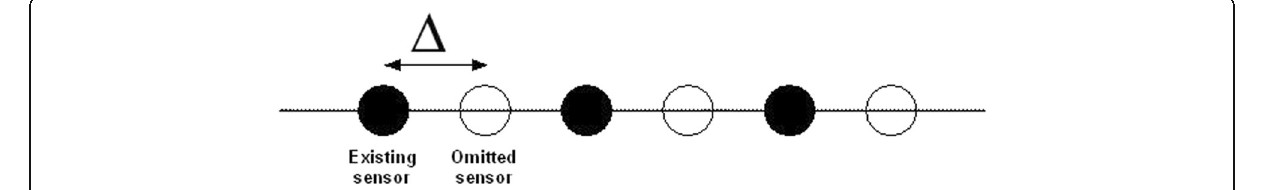
Fig. 7 The dark circles denote the active sensors and the white circles the omitted